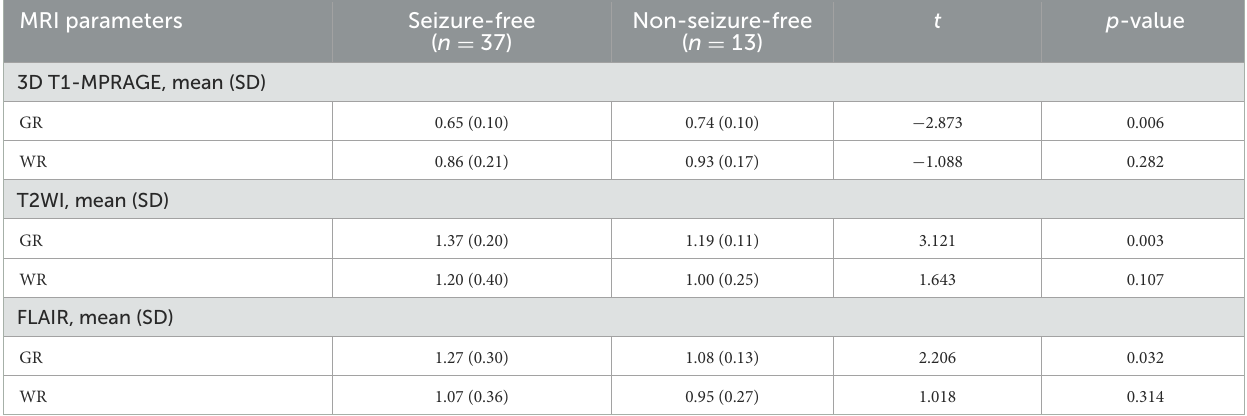
TABLE 2 Comparison of MRI parameters between the seizure-free and non-seizure-free groups. MRI parameters